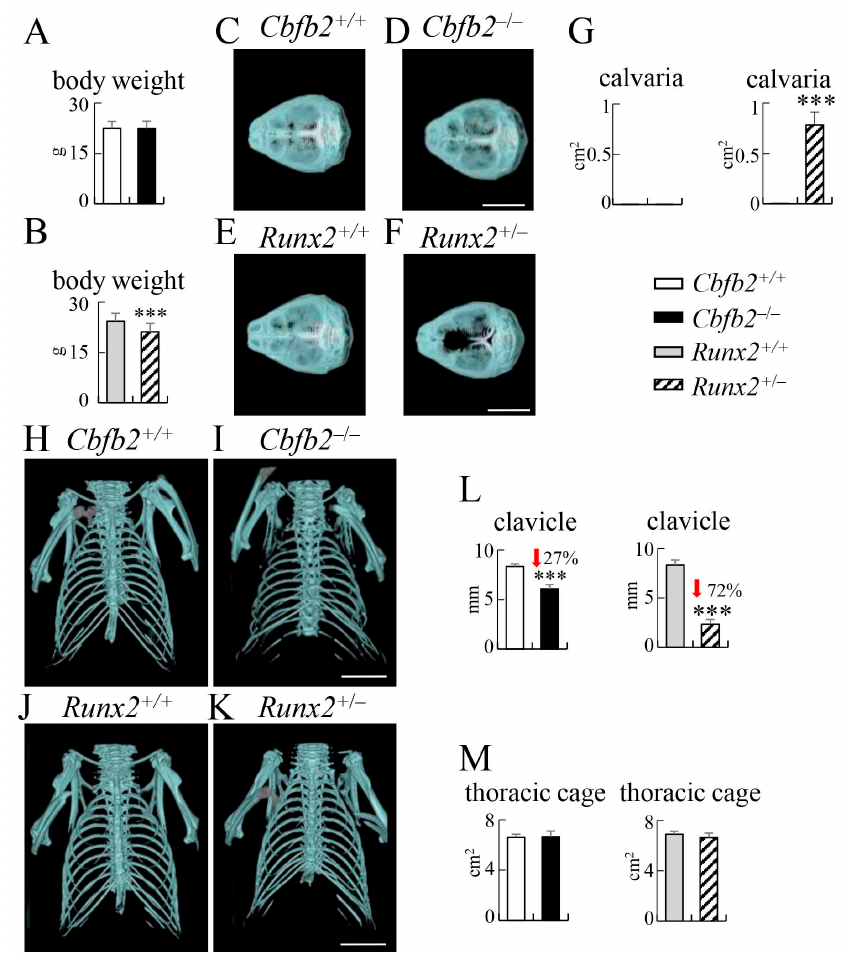
Figure 9. Micro ‐ CT analysis of calvaria, clavicles and thoracic cage in Cbfb2 –/– and Runx2 +/– mice. ( A , B ) Body weights of male mice at 10 weeks of age. n =14–19. ( C – M ) Calvaria ( C – F ), clavicles and thoracic cage ( H – K ), unmineralized area in calvaria ( G ), the length of clavicles ( L ) and the area of thoracic cage ( M ) in male Cbfb2 +/+ , Cbfb2 –/– , Runx2 +/+ and Runx2 +/– mice at 14 weeks of age. Scale bars: 1 cm. Data are shown as the mean ± SD. *** p < 0.001. The number of mice analyzed: Cbfb2 +/+